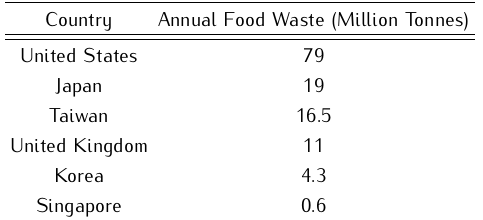
Table 1. Amount of Food Waste from Different Countries in 2010